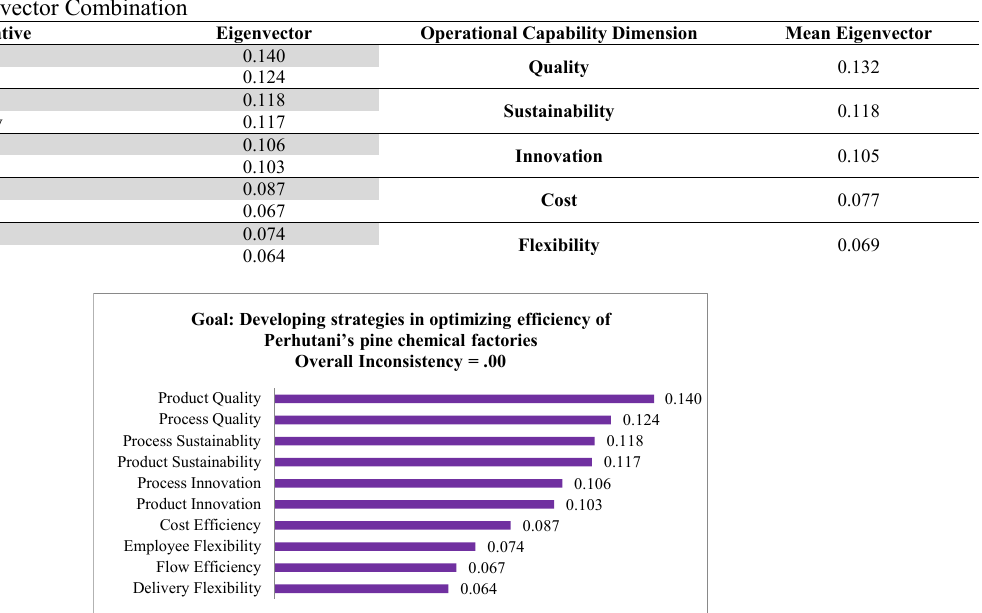
Fig. 4. Eigenvector for each alternative of operational capability